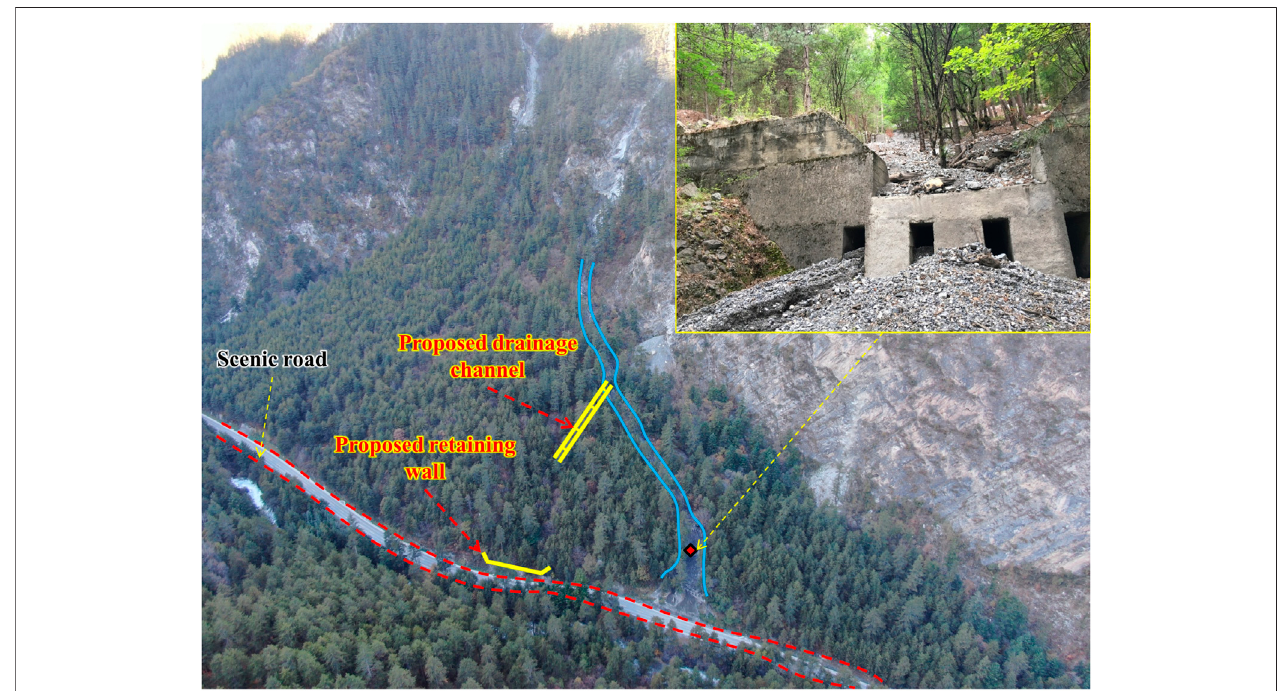
FIGURE6| Controlengineering layoutofPingshitouGully(afterthedebris fl owevent onJuly22,2019). Thebluelineinthe fi gure representsthemainchannel. The drainagechannelandtheretainingwallinthe fi gurearetheproposedengineeringprojectsdescribed in ApplicationofthePlanningMethodfortheXiajijieLake,Zhuozhui, Pingshitou, Xuan, and West-Zhuozhui Debris Flow Gullies section.